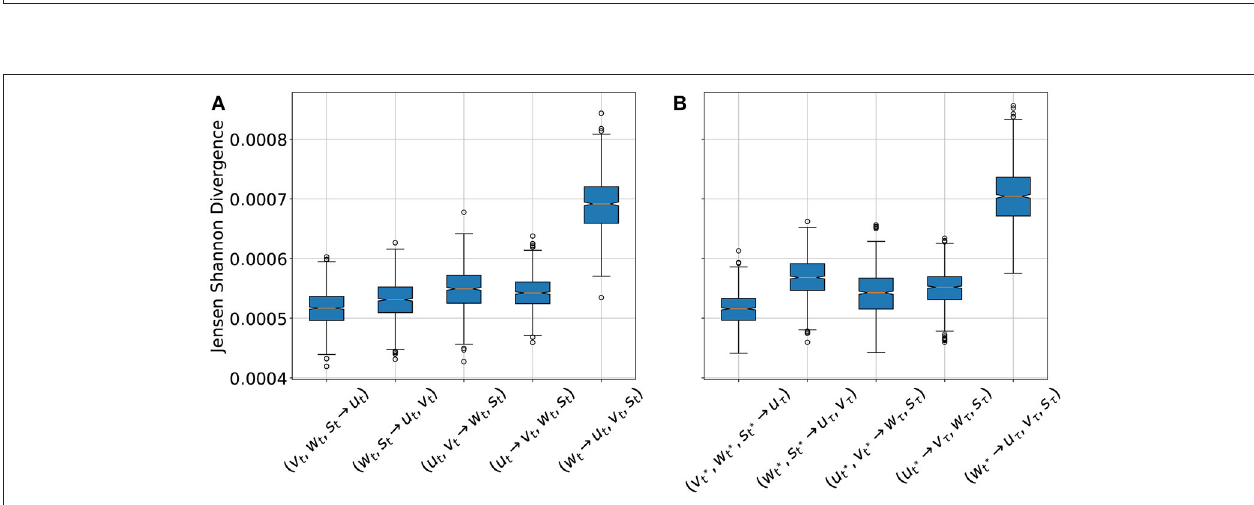
FIGURE 6 | Jensen-Shannon-Divergence (JSD) of true and estimated fields for different cross estimation tasks. In cases where more than one variable is estimated the mean value of the JSDs of the estimated variables is given. (A) Cross estimation for the cases ( v t , w t , s t → u t ),( w t , s t → u t , v t ),( u t , v t → w t , s t ),( u t → v t , w t , s t ), and ( w t → u t , v t , s t ), based on the input from the BOCF simulation. (B) Cross estimation of future values of not measured variables for the cases ( v t ∗ , w t ∗ , s t ∗ → u τ ),( w t ∗ , s t ∗ → u τ , v τ ),( u t ∗ , v t ∗ → w τ , s τ ),( u t ∗ → v τ , w τ , s τ ), and ( w t ∗ → u τ , v τ , s τ ) based on the forecast of the data driven model for a period of τ = 1,000, where t ∗ denotes 10 successive snapshots at times 0,0.1, ... ,0.9 constituting the input . In both diagrams the orange line is the median value for each case, the box extends from the lower to upper quartile values. The whiskers extend from the box to show the range of the data. Flier points are those past the end of the